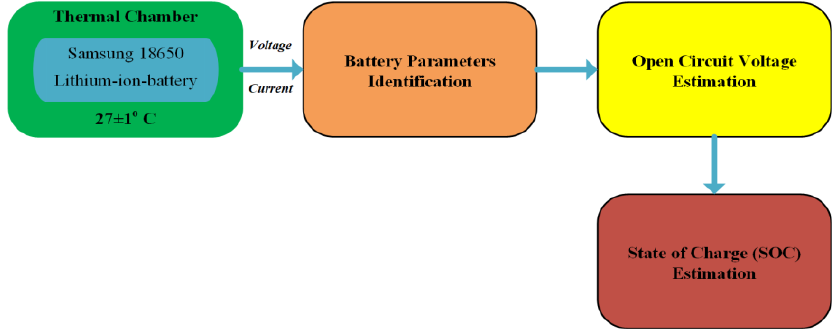
Figure 4. General diagram of the proposed methodology.